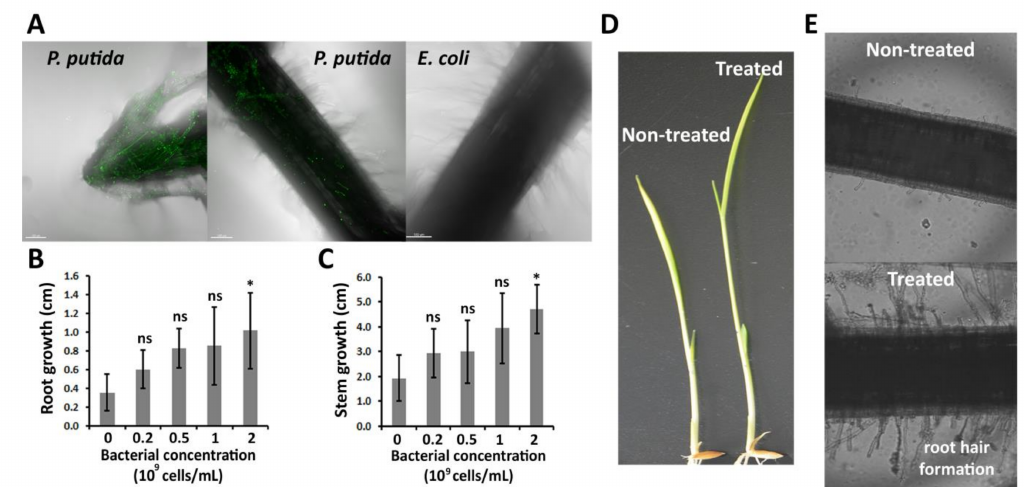
Figure 1. Colonization and growth promotion e ff ects of Pseudomonas putida on rice plants. ( A ) P. putida transformants colonizing root hair and cap. Scale bar = 100 µ m. ( B ) Root and ( C ) stem growth of rice plants in the presence of P. putida . The length of roots and stems was measured 2 days after P. putida treatment (early interaction stages). ( D ) Images of rice plants treated with 0 and 2 × 10 9 cells / mL P. putida . ( E ) Microscope images showing the root hair formation of rice plants treated with 0 and 2 × 10 9 cells / mL P. putida . The images were taken 2 days after the bacterial treatment. Significance levels at p < 0.05 (*) and no significance